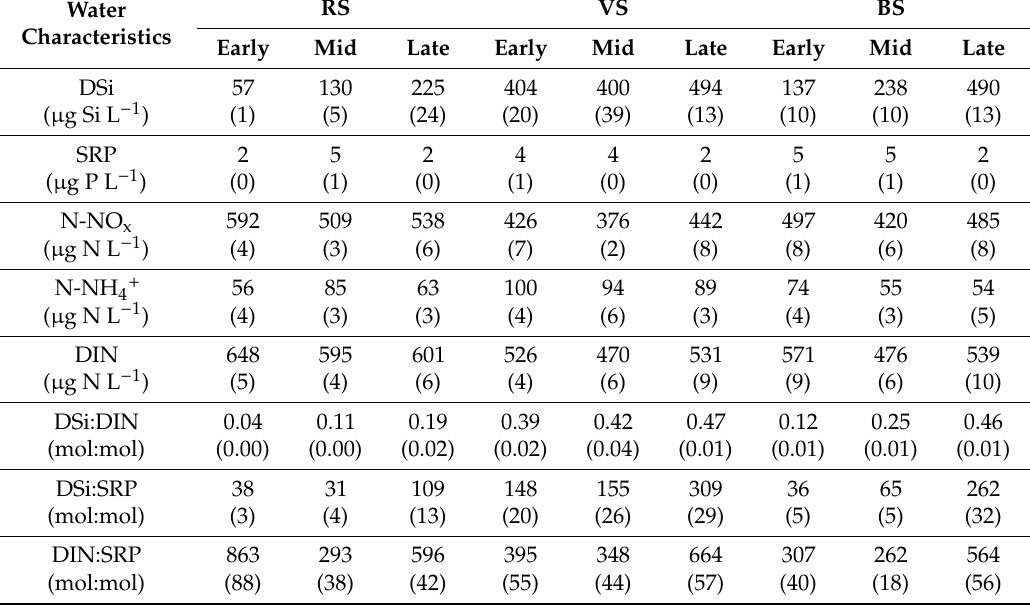
Table 2. Dissolved silica (DSi), soluble reactive phosphorus (SRP), ammonium (N-NH 4 + ), nitrate and nitrite (N-NO x ) and dissolved inorganic nitrogen (DIN) concentration and DSi:DIN, DSi:SRP and DIN:SRP molar ratios in the water column at the three investigated sites (RS = rocky shores; VS = vegetated sediments; BS = bare sediments). All data represents the mean of three replicates (standard error in